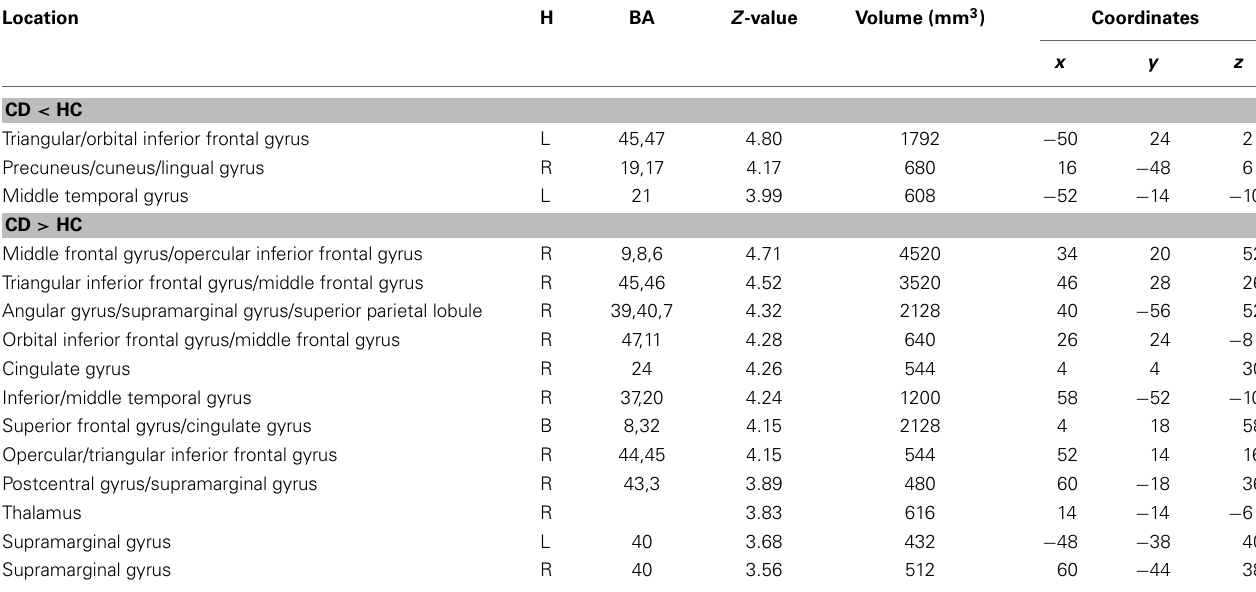
Table 2 | Comparisons between congenitally deaf individuals (CD) and hearing controls (HC) for the rhyming task. Location